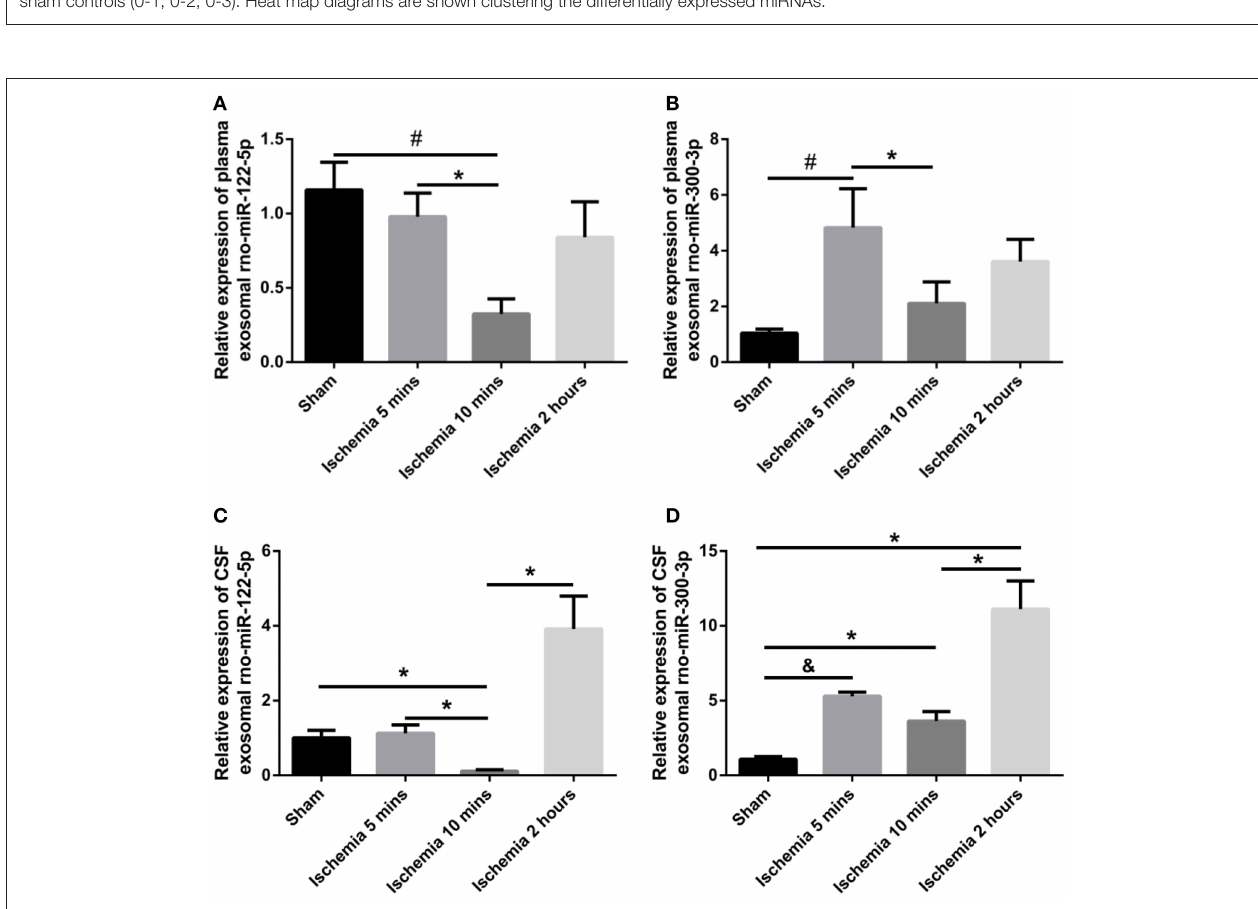
Frontiers in Aging Neuroscience |